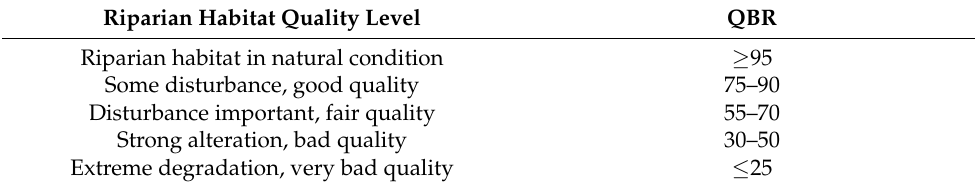
Table 1. Quality classes according to the QBR index [35].